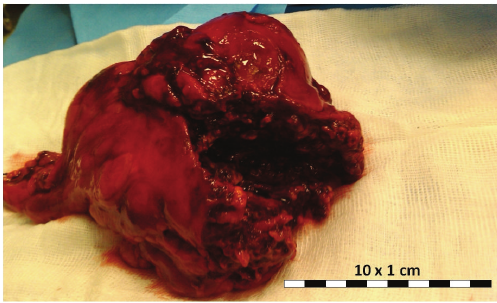
Figure 2: Total nephrectomy specimen revealing an altered renal anatomy due to parenchymatous degeneration.